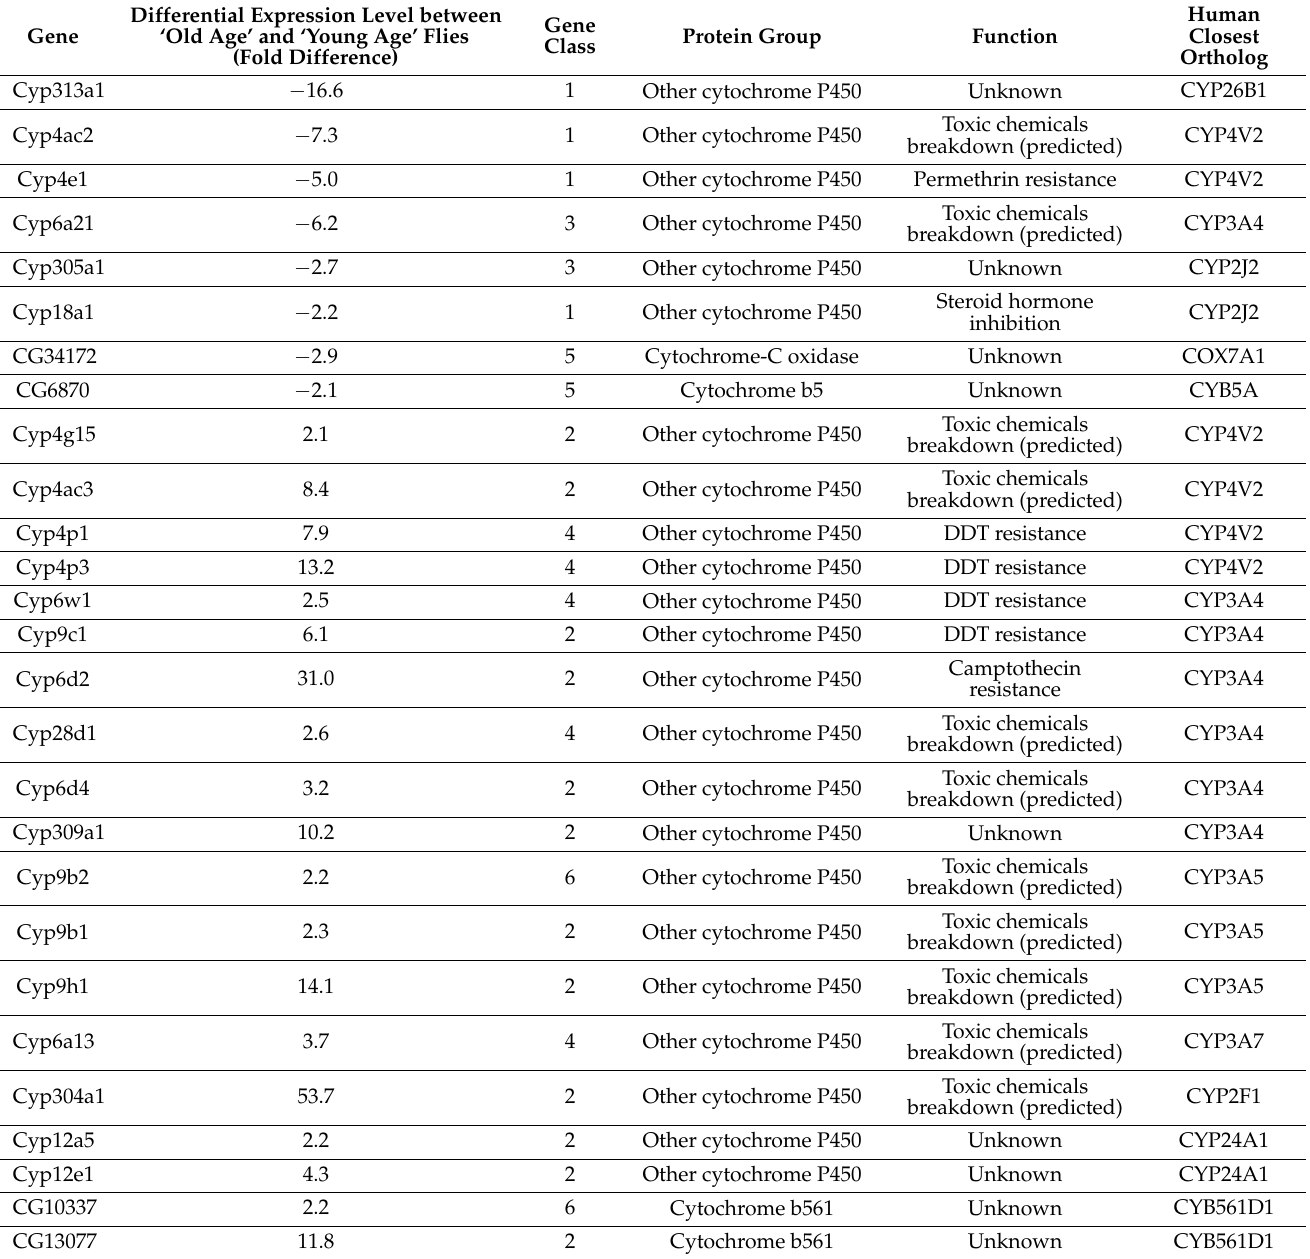
Table 4. DEGs that encode for a member of the cytochrome family. In total, 23 out of 27 DEGs are related to the Cytochrome P450 subfamily. A negative differential expression level means that this gene had higher expression in young age flies compared to its expression in old age flies. A positive differential expression level means that this gene had a lower expression level in the young age flies compared to its expression in old age flies. The first part of the table includes DEGs that are downregulated during aging. The second part of the table includes DEGs that are upregulated during aging.